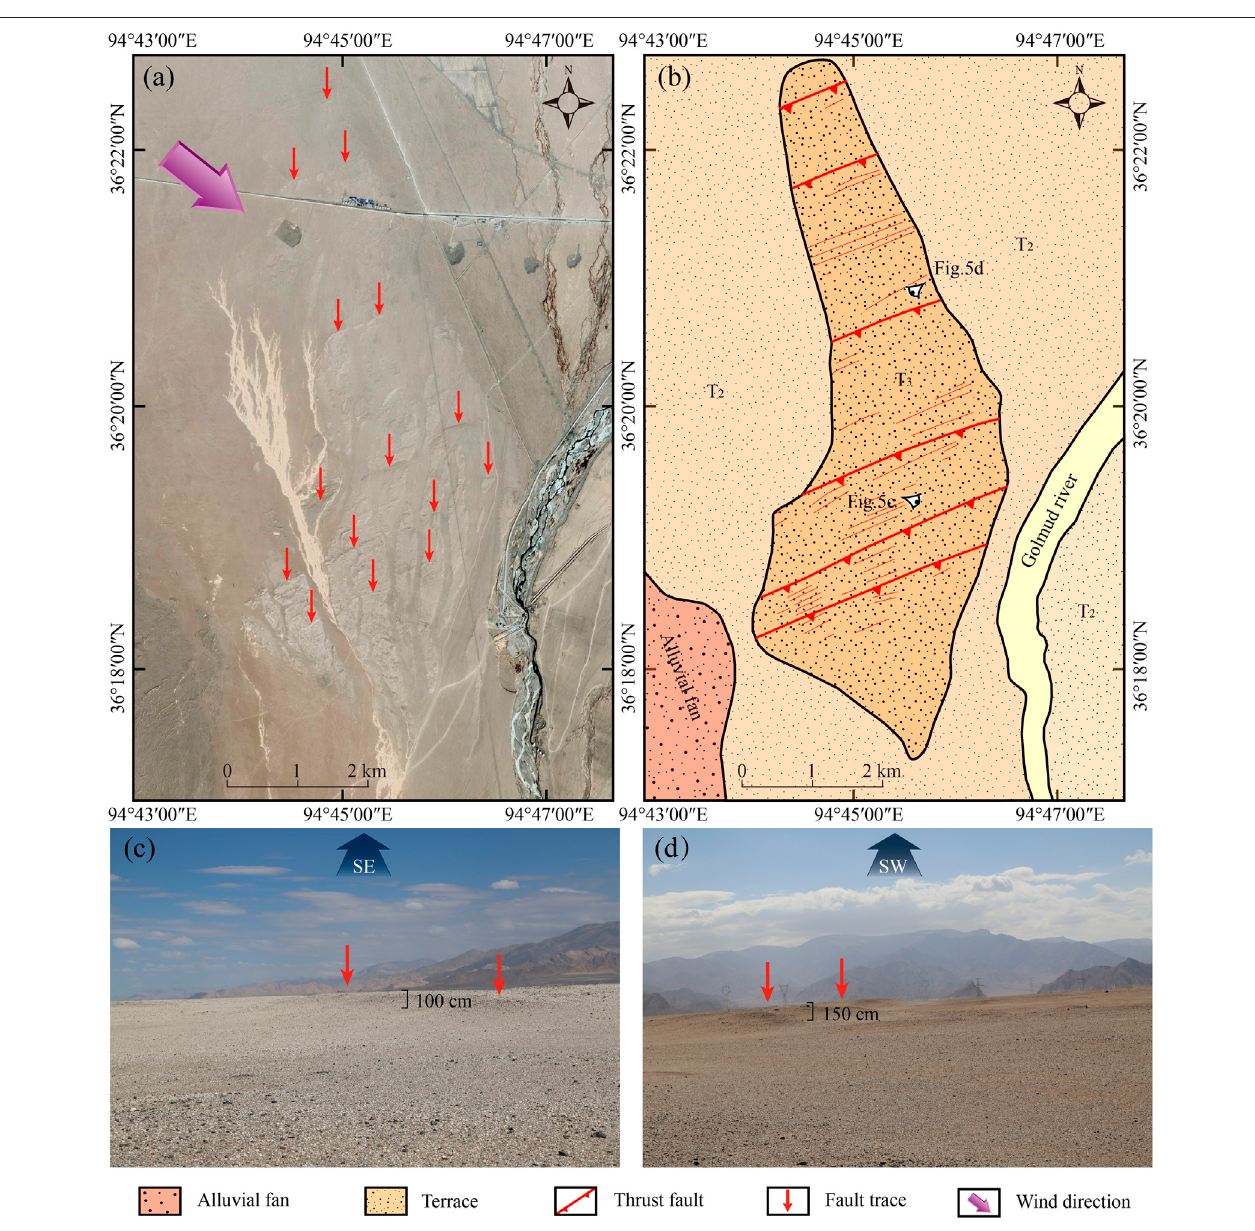
FIGURE 5 | (A) Image from Google Earth image at the Golmud river site. Red arrows indicate the active fault trace. Pink arrow indicates wind direction. (B) Interpretation of the Terraces, alluvial fan and faults. Red thick solid lines represent continuous fault traces, and the height of the scarps is more than 1 m. Red thin solid lines represent interrupted sub-parallel fault traces. (C,D) Field photos of the